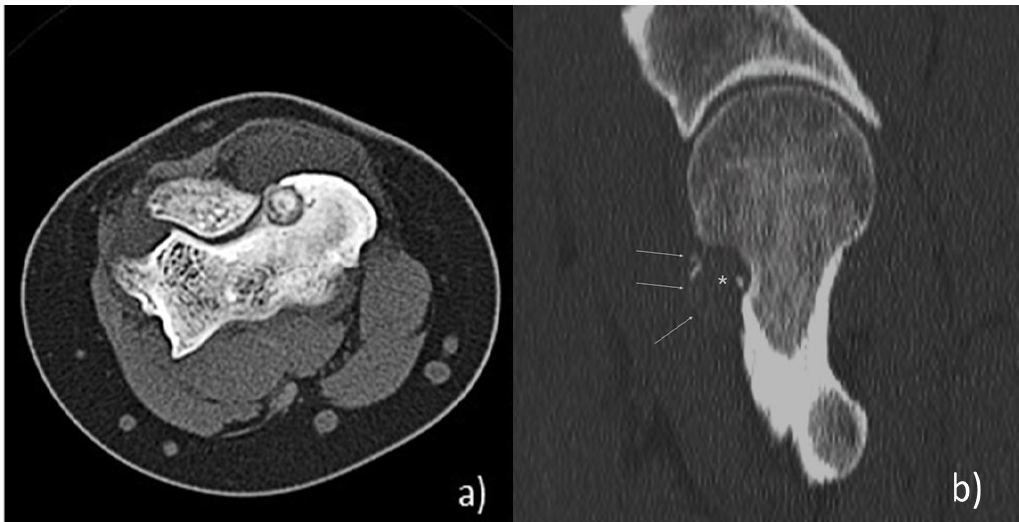
Figure 1. ( a ) Axial-CT images of intra-articular OB localized at the humeral epicondylus. The “nidus” has a rounded shape and well defined tumor margins, with high degree of internal calcifications; no presence of perilesional sclerosis. ( b ) Sagittal-CT images of OB localized at the femoral neck, with expansive aspect: the “nidus” is entirely radiolucent, with no sclerosis and small radio-opacities; the bone cortex is perfectly intact, although expanded and thinned.